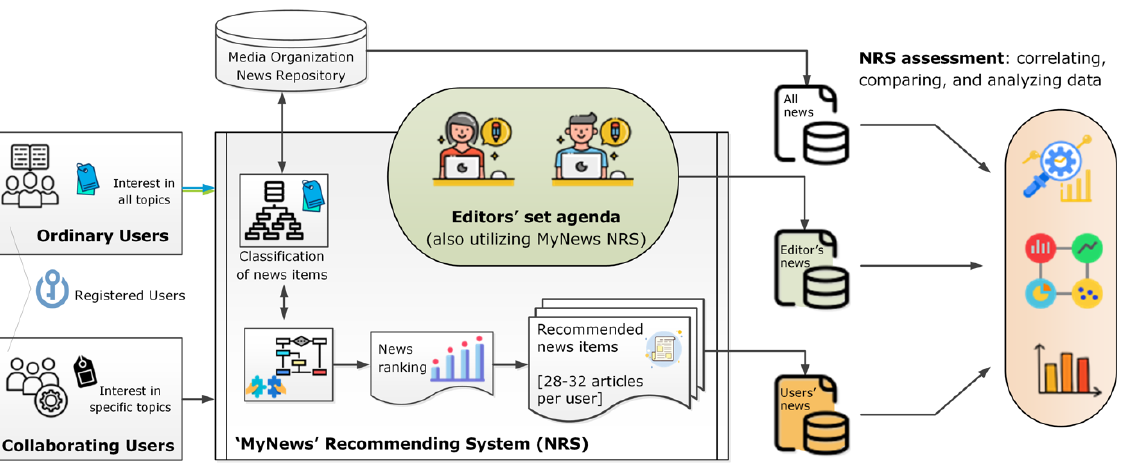
Figure 5. Visualization of the experimental approach: Design and